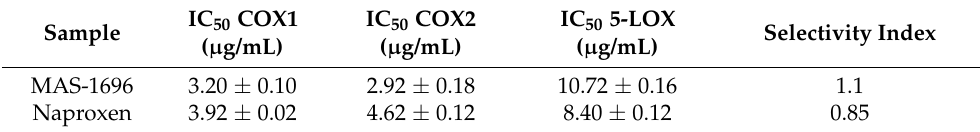
Table 2. Inhibition percentage and IC 50 values of MAS-1696 against cyclooxygenase and 5-lipoxygenase